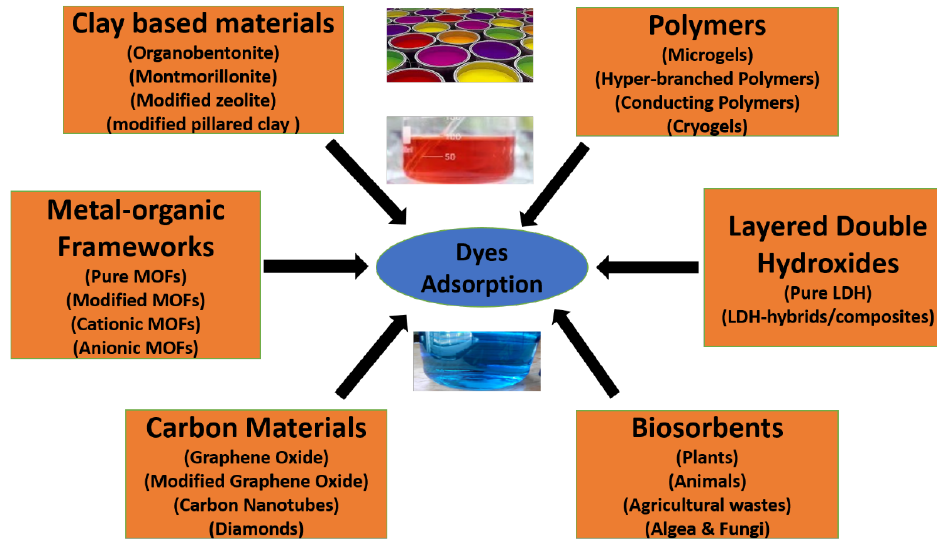
Figure 2. Dye adsorption over different kinds of designed